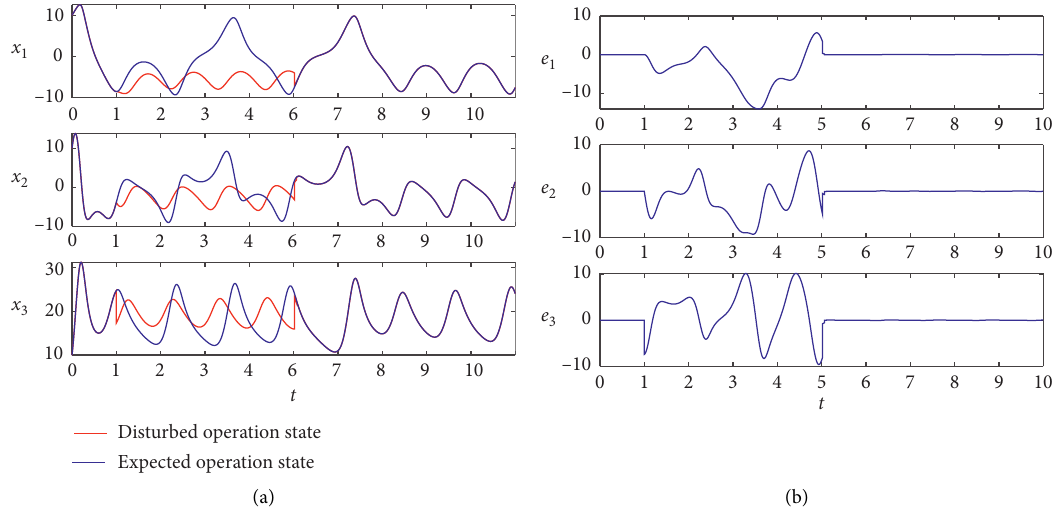
Figure 7: Impulsive synchronization of supply chain system (27). (a) Time series of x